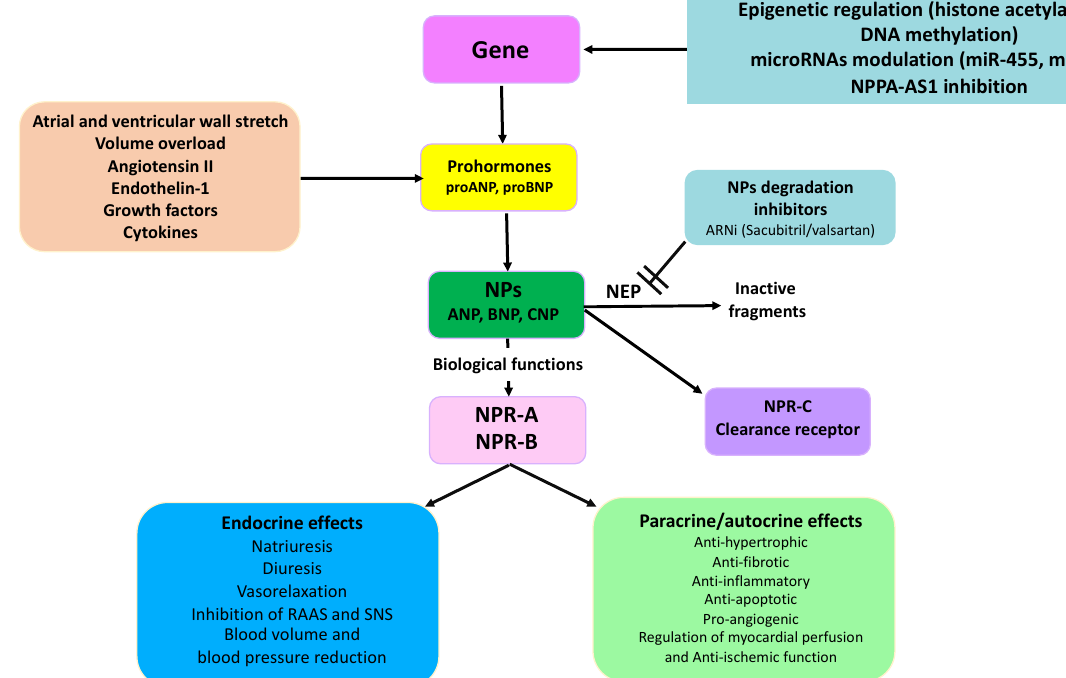
Figure 1. Schematic representation of the natriuretic peptide system from secretion to biological actions. Legend to Figure 1. NPs are produced by cardiomyocytes upon hemodynamic and neuroendocrine stimuli. Cardiomyocytes store prohormones, namely proANP and proBNP, that are then processed to the biologically active peptides ANP and BNP. NPs act on target cells through specific cGMP ‐ coupled receptors.